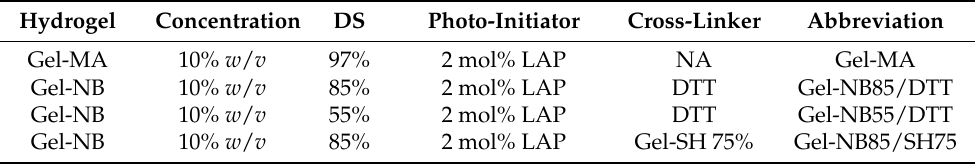
Table 1. Experimental set-up: four different gelatin biomaterials were evaluated as hydrogels for tenocyte culture. Tissue culture plastic was included as control group. DS: degree of substitution; DTT: 1,4-dithiotreitol; gel-MA: methacrylated gelatin; gel-NB: norbornene-functionalized gelatin; gel-SH: thiolated gelatin; LAP: lithium(2,4,6-trimethylbenzoyl) phenylphosphinate.